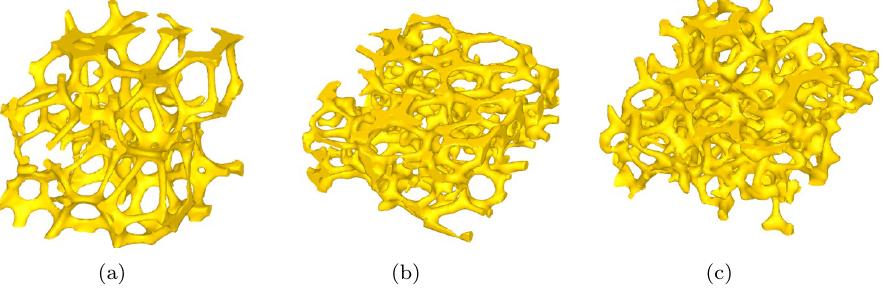
Figure 1. Electron microscope images of the cross section of a strut of Specimen 1: ( a ) inverse pole Figure 1: Electron microscope images of the cross section of a strut: (a) inverse pole figure figure (IPF) map, ( b ) image quality (IQ) map, and ( c ) pole figures (PFs). Contours of pole figures: (IPF) map, (b) image quality (IQ) map, and (c) pole figures (PFs). Contours of pole figures: 0.65, 1.05, 1.45, 1.85, 2.25, 2.65